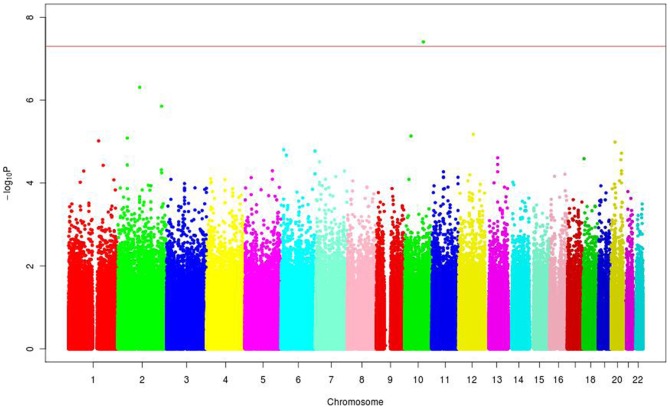
Manhattan plot showing results of a GWA analysis in 1949 Lebanese patients for 513,079 SNPs. The Y-axis corresponds to the significance of the association (-log10 p-values). The X-axis represents the physical location of the variant colored by chromosome.